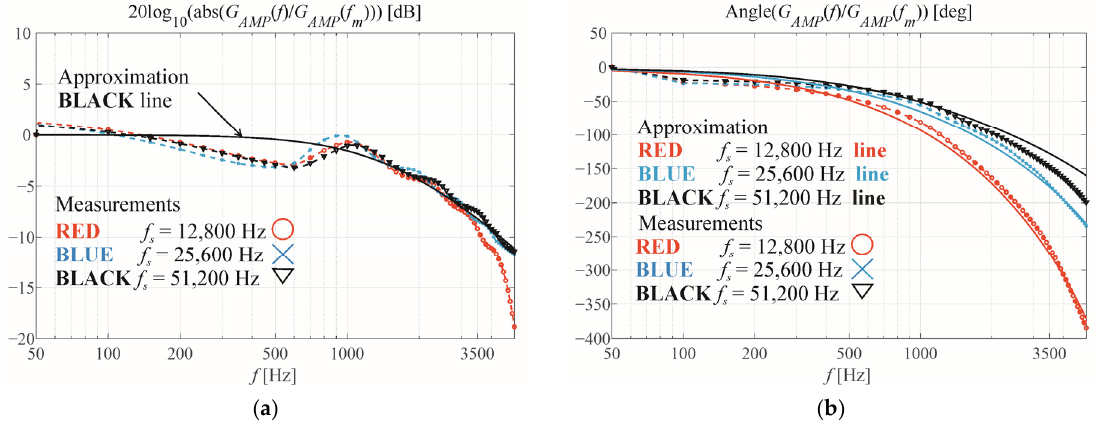
Figure 6. The measured and approximated Bode plots ( a ) magnitude and ( b ) phase of the voltage- measuring